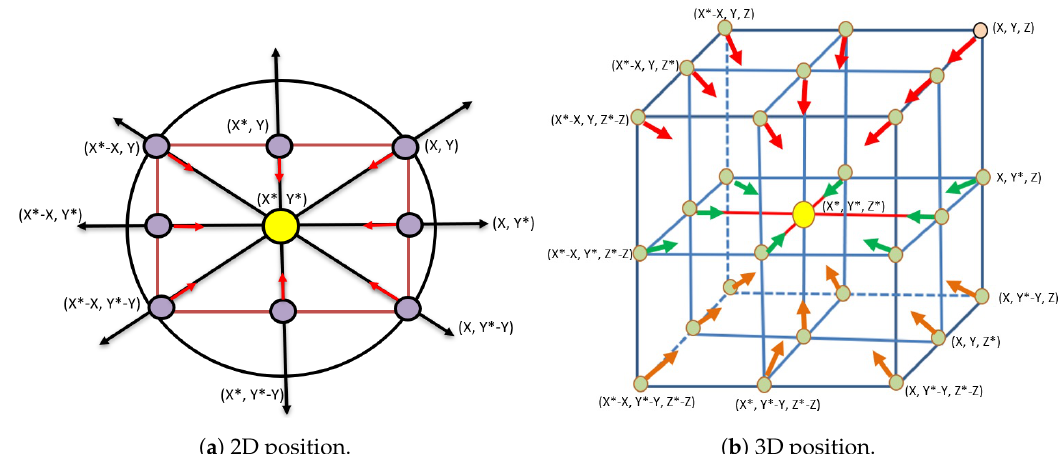
Figure 4. Potential 2D and 3D locations of whales in the neighbourhood of the prey.